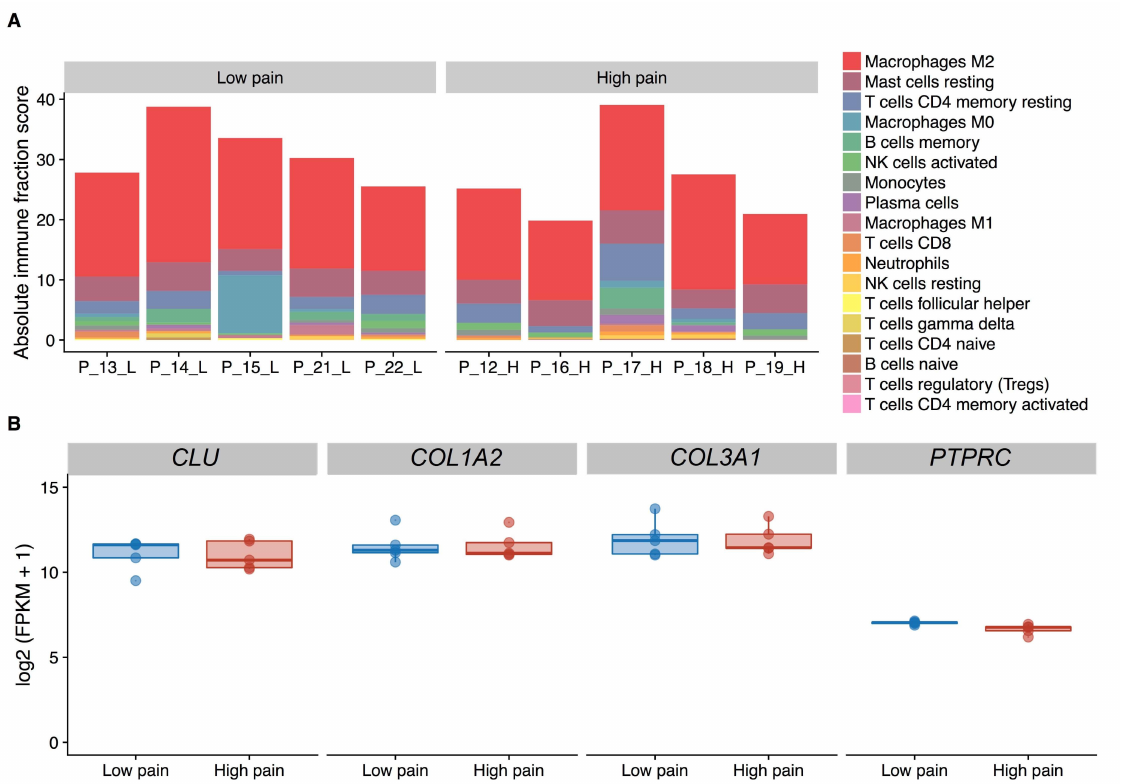
Figure 1. Deconvolution analysis of the cell composition in synovial tissue extracts based on RNA-sequencing data. ( A ) Fraction of leukocyte type content as inferred by CIBERSORT. ( B ) Expression levels of fibroblast ( CLU , COL1A2 , COL3A1 ) and leukocyte ( PTPRC ) marker genes. FPKM, Fragments Per Kilobase